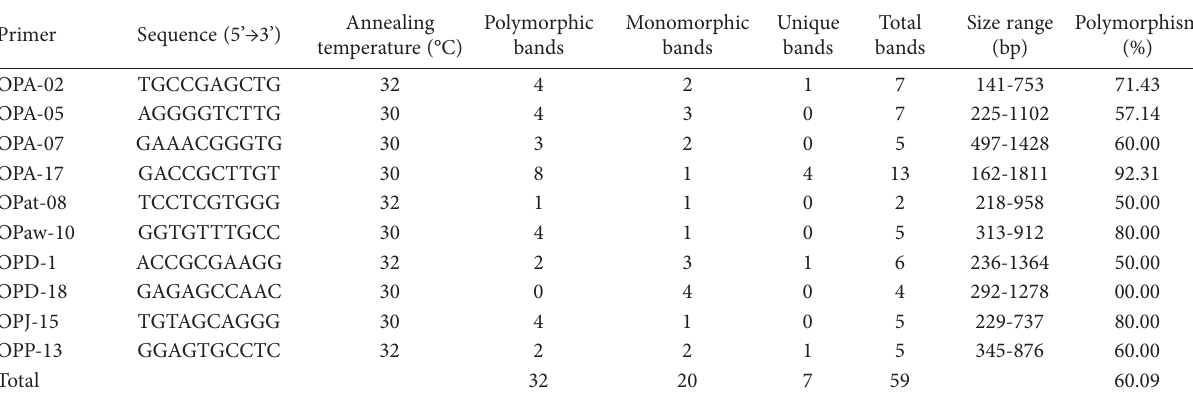
Table 4. Ten RAPD primers, their sequences, annealing temperature, size of amplified fragments (bp), total number of amplified fragments, number of polymorphic bands and unique bands identified per primer used to access genome stability of Vicia faba Misr 3 cultivar under the influence of Al stress.